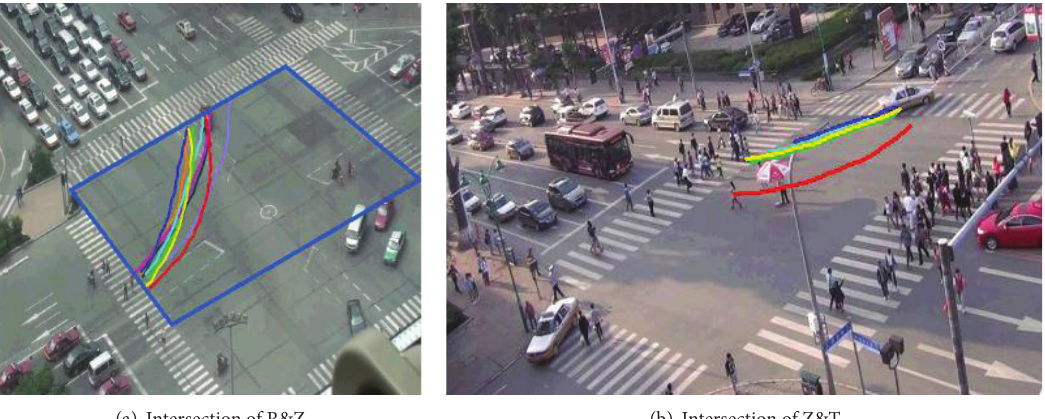
Figure 3: Vehicles’ trajectories inside a green phase.